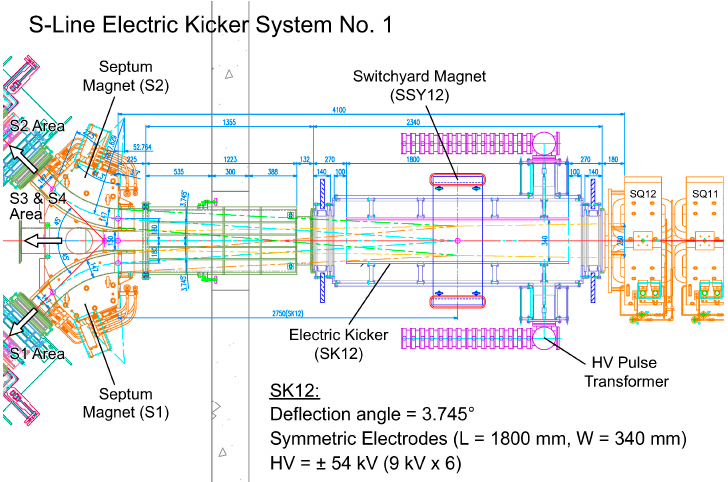
Figure 10. Layout of the S-line electric kicker system that delivers single-pulsed muon beam to areas S1 and S2. The muon beam can also be sent straight to areas S3 and S4, where installation of a similar kicker system is planned.